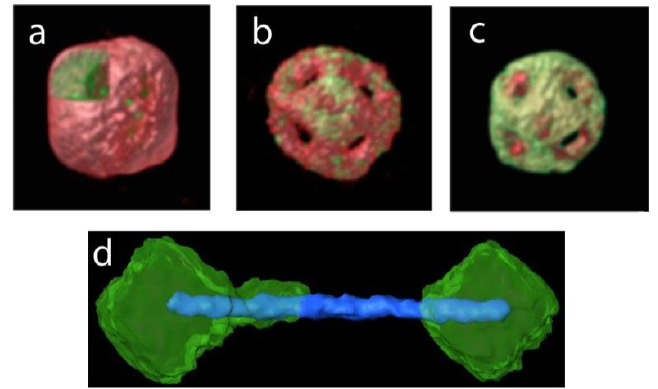
Figure 8. ( a – c ) 3D visualization of the EDS reconstructions of three different nanoparticles at different stages of a galvanic process reaction. Au and Ag are represented by red and green, respectively; ( d ) 3D visualization of the EDS reconstruction of a Fe-Co nanodumbbell, revealing the distribution of the elements in 3D. Co and Fe are represented by blue and green, respectively [82,83].